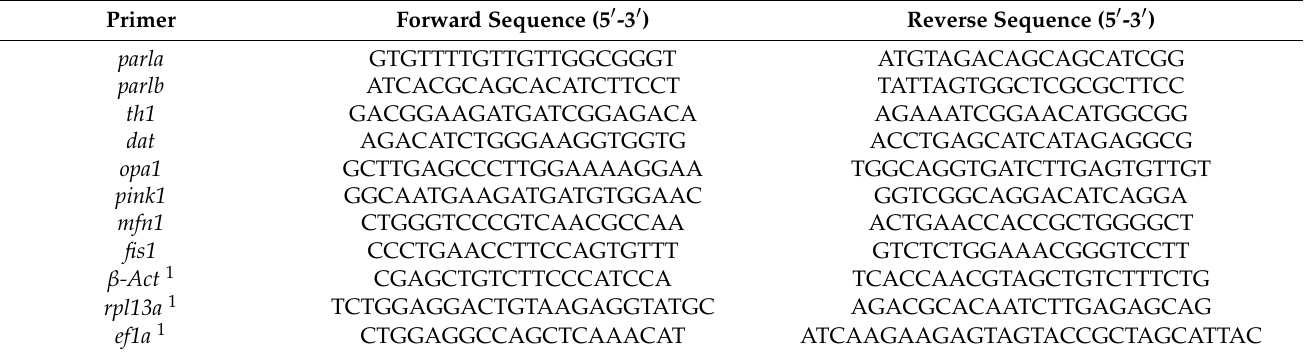
Table 3. List of primers designed for